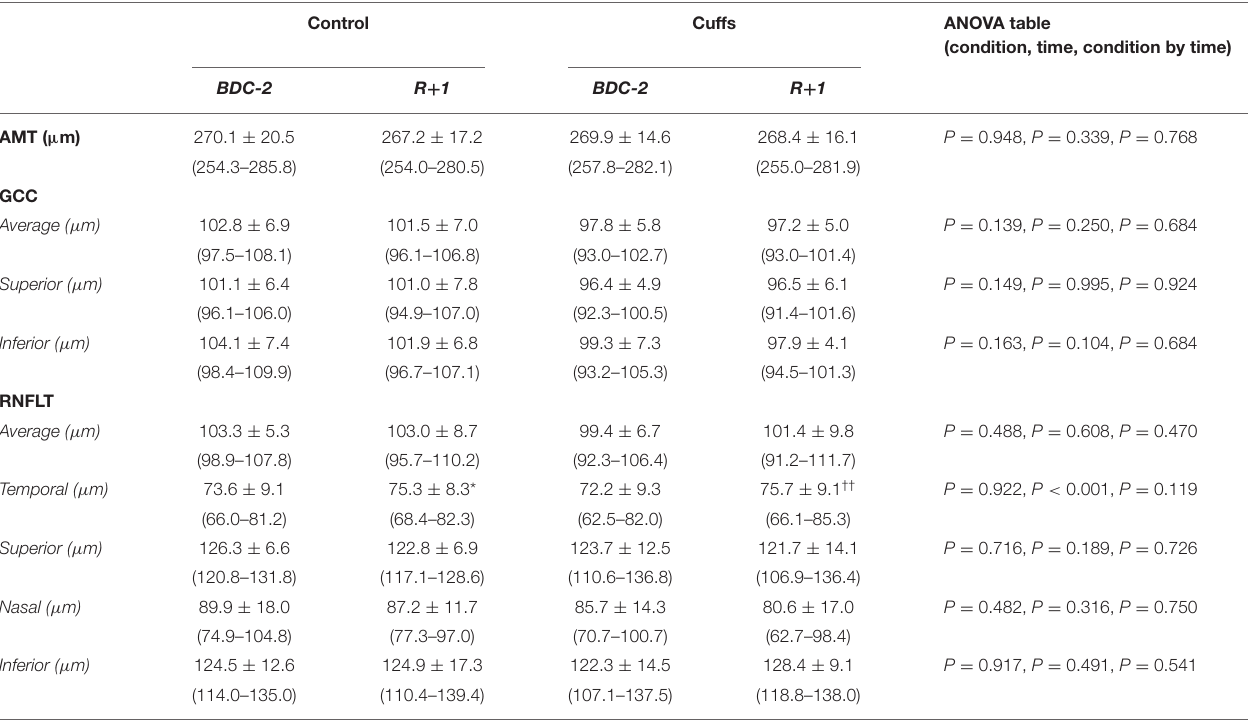
TABLE 3 | Optical coherence tomography